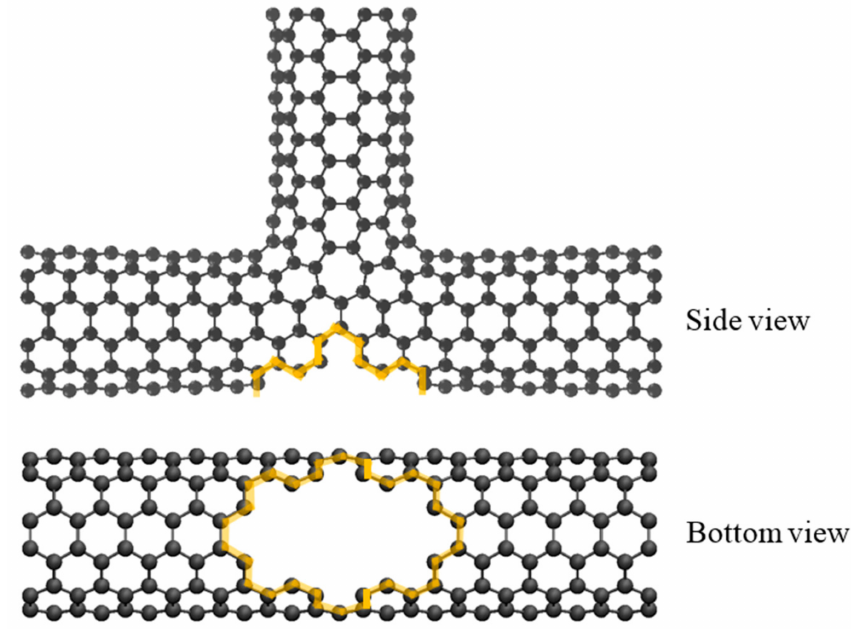
Figure 2. Defect-containing T-junction